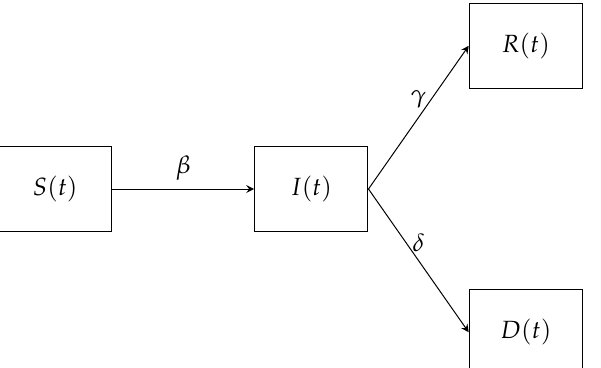
Figure 1. A schematic flow diagram representing a Susceptible-Infected-Recovered-Dead (SIRD) COVID-19